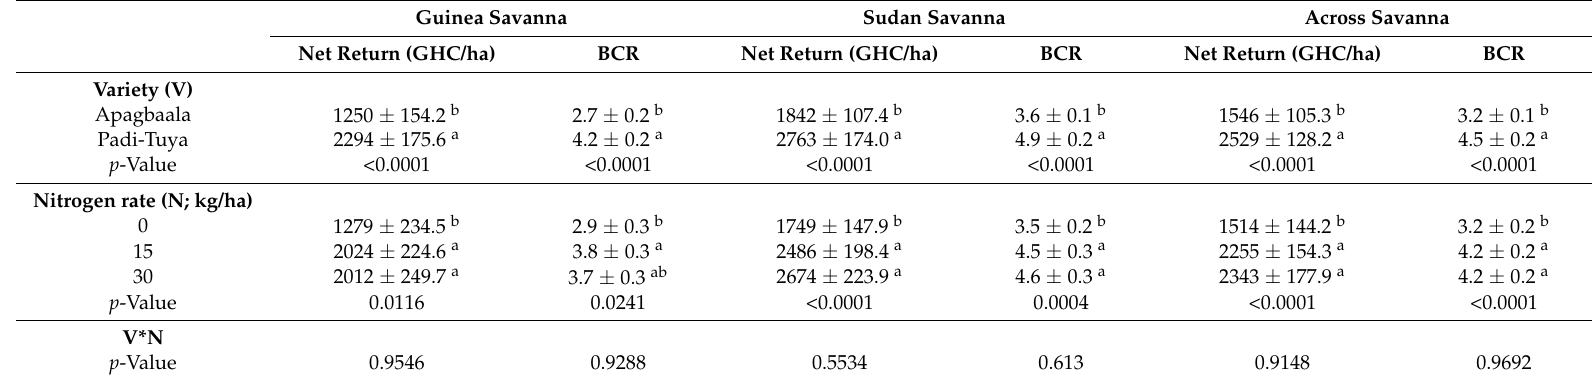
Table 3. Net return and BCR from cowpea grain and fodder yields as affected by variety and N fertilizer rates, 2013 and 2014 cropping seasons. Guinea Savanna Sudan Savanna Across